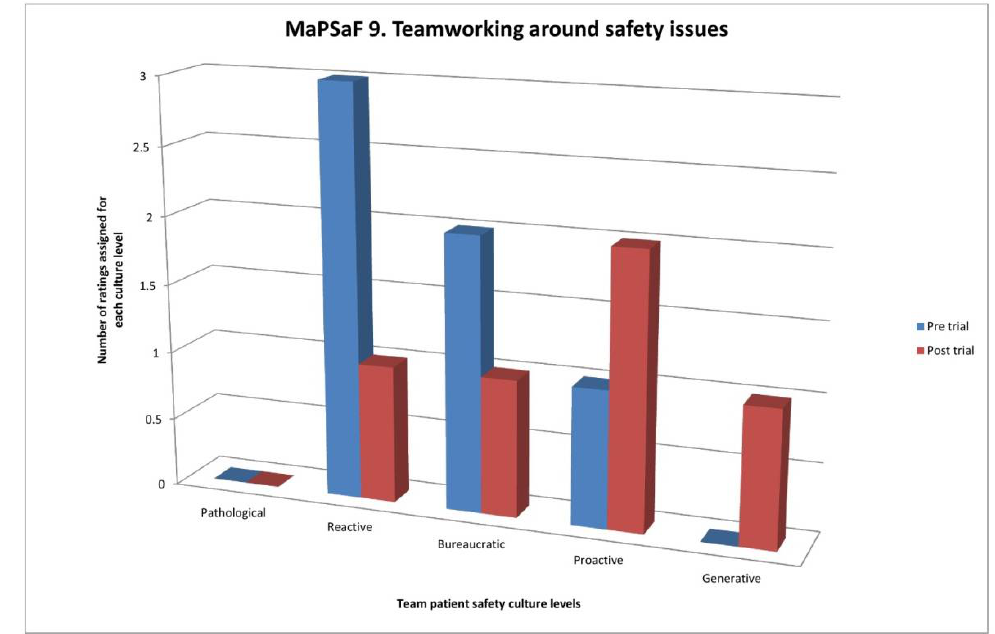
Figure 6. Team working around safety issues.